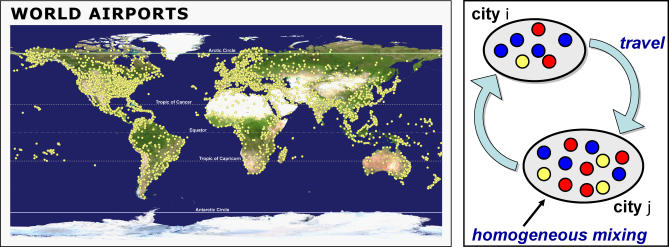
Representation of the Metapopulation Model AdoptedThe model includes 3,100 airports in 220 countries worldwide. The map portrays the locations of urban airports worldwide; geographical data are obtained from open sources on the Internet and mapped with ArcGIS software (http://www.esri.com/software/arcgis). A schematic illustration represents the patch or metapopulation model adopted, in which the total population is divided into subpopulations each corresponding to the urban area surrounding each airport. Filled circles inside each subpopulation represent individuals, and the colors correspond to a specific stage of the disease. Homogeneous mixing for the infection dynamics is assumed inside each urban area, and different urban areas; subpopulations are coupled by means of air travel, according to the International Air Transport Association traffic fluxes.